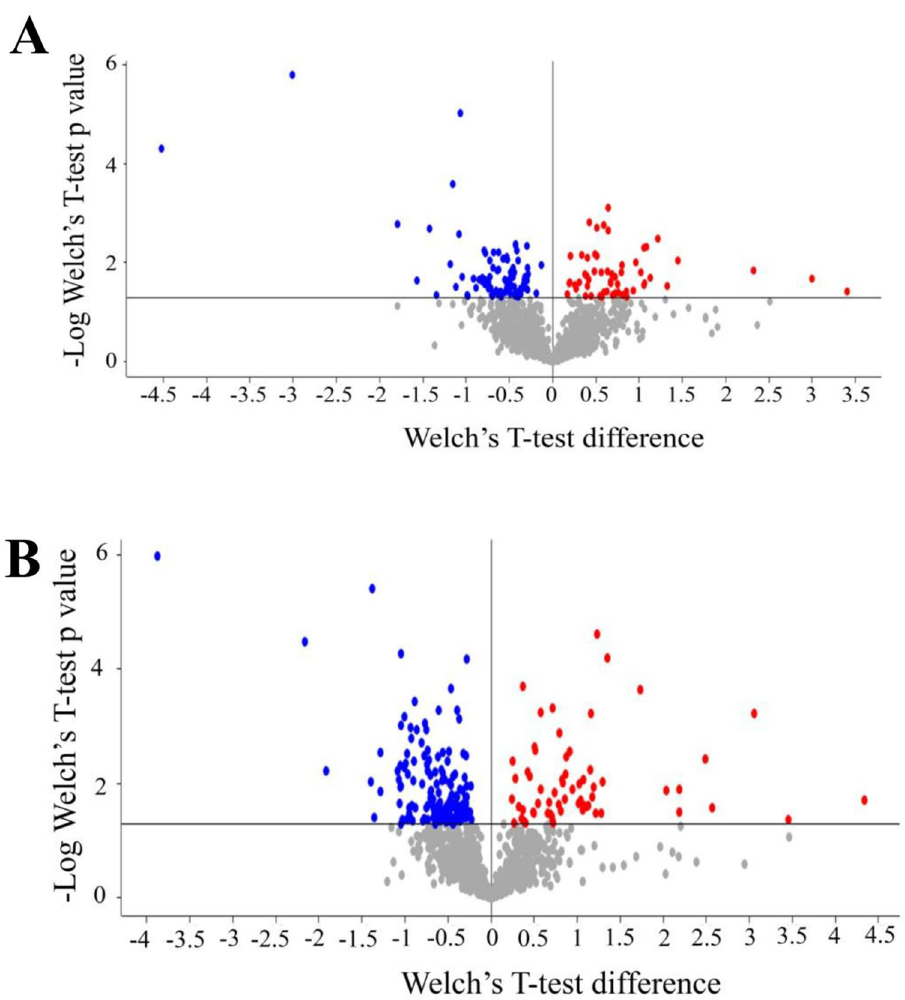
Figure 7. Volcano plots comparing the proteome of zebrafish at 18 °C and 34 °C with 26 °C, kept as the control condition. Volcano plots of the proteins differentially expressed in the comparison 18 °C versus 26 °C ( A ) and 34 °C versus 26 °C ( B ), respectively. Proteins were considered differentially expressed if showed significant t-test difference (Welch’s test P ≤ 0.05). Proteins more expressed at stress temperatures (18 °C or 34 °C) compared to control are shown in blue while proteins less expressed in stress conditions are shown in